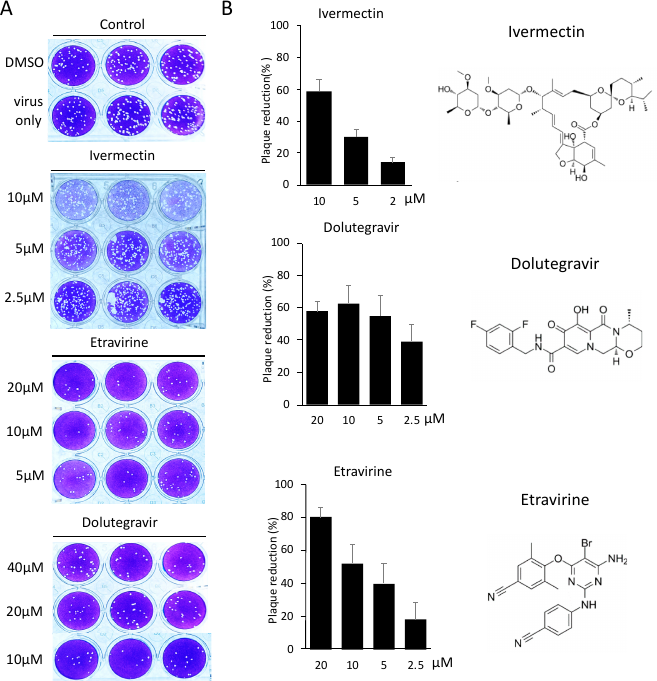
Figure 4. Neutralization efficiency of entry inhibitors was determined by SARS-CoV-2 PRNT. ( A ) Representative images of SARS-CoV-2 PRNT performed with selected entry inhibitors. Specifically, SARS-CoV-2 was pre-incubated with entry inhibitors for one hour, followed by one-hour infection with susceptible VeroE6 cells. Plaques forming were measured 5 days post-infection. ( B ) Neutralization efficiencies of entry inhibitors were determined by quantifying plaque numbers and displayed as percentage of plaque reduction. Chemical structures of entry inhibitors are shown on the right